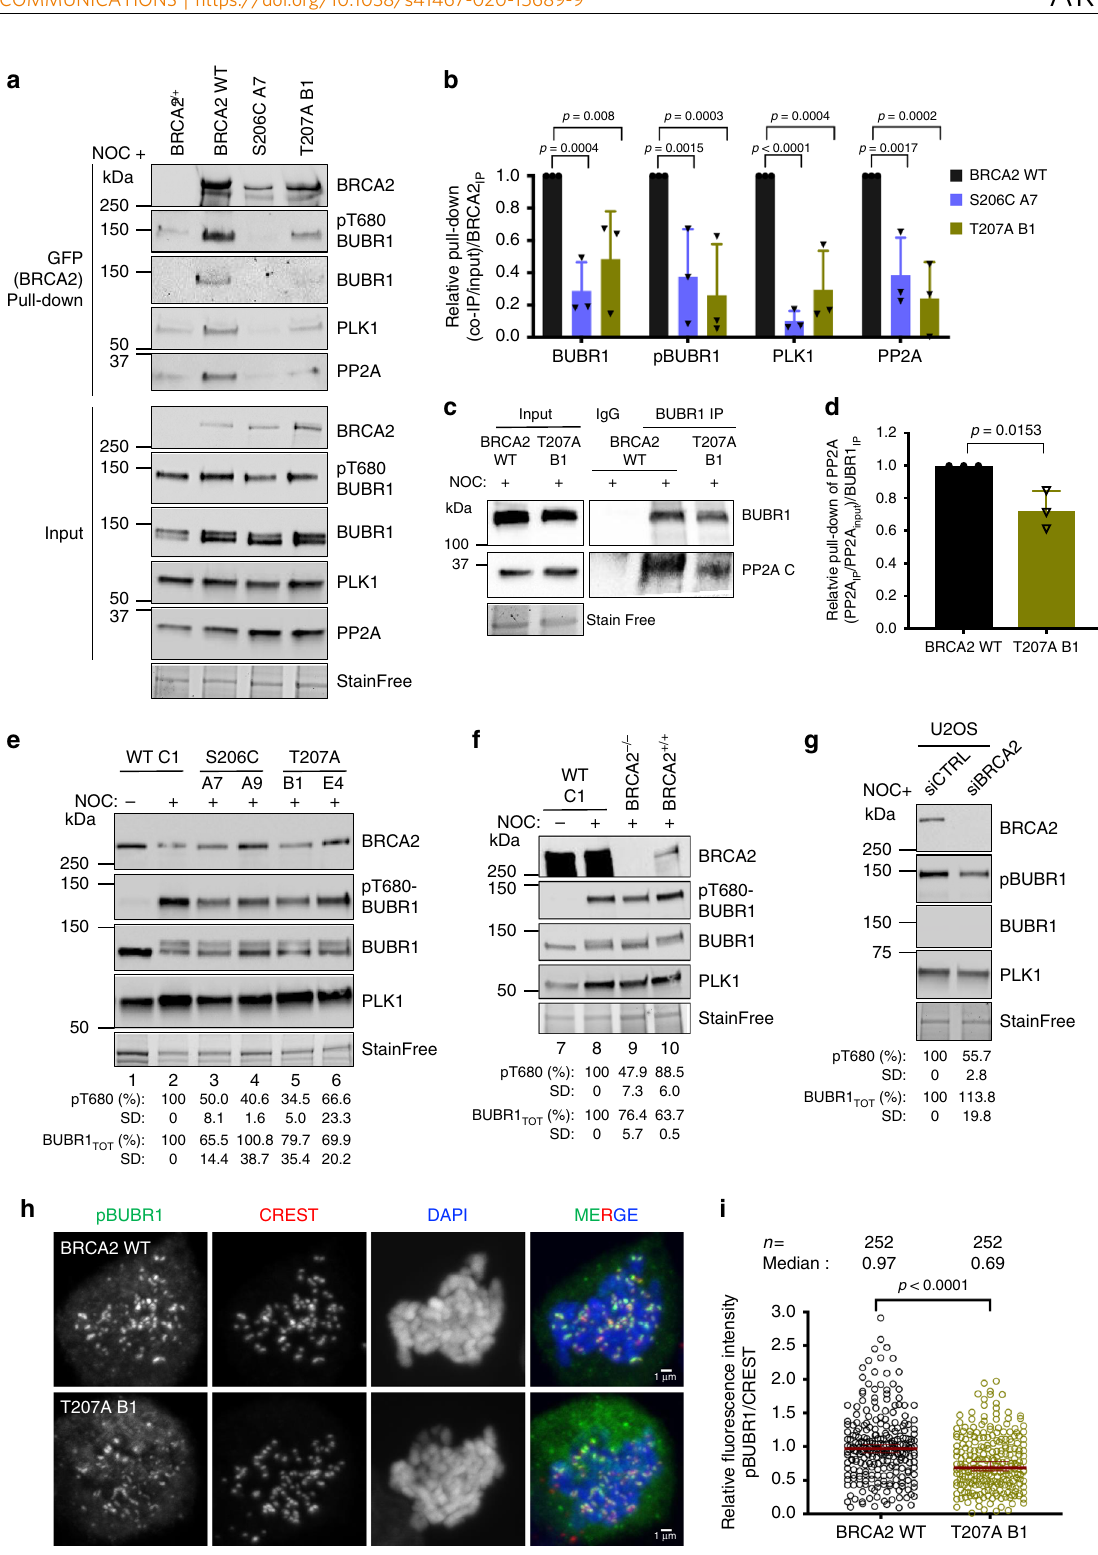
Fig. 6a, b), nor to an increased interaction of PLK1 with BUBR1 in the mutated cells (Supplementary Fig. 6c, d). Together, these results strongly suggest that docking of PLK1 onto BRCA2 T207 facilitates the formation of a complex between phosphorylated BUBR1 and PP2A at the kinetochore that is essential for the stability of microtubule – kinetochore attachments with direct consequences in chromosome align- ment. The fact that BUBR1-3D cannot rescue the